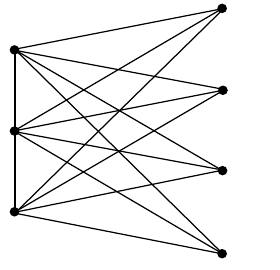
Figure 4. The graph K 1 ∪ K 2 ∪ K 4